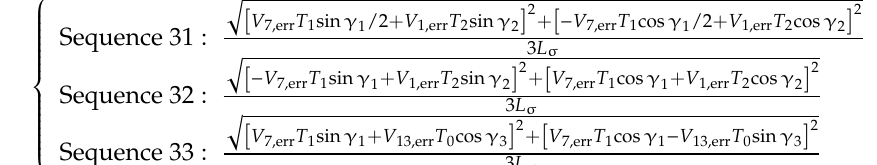
Table a1 The coordinate of three vertexes of current ripple triangle.